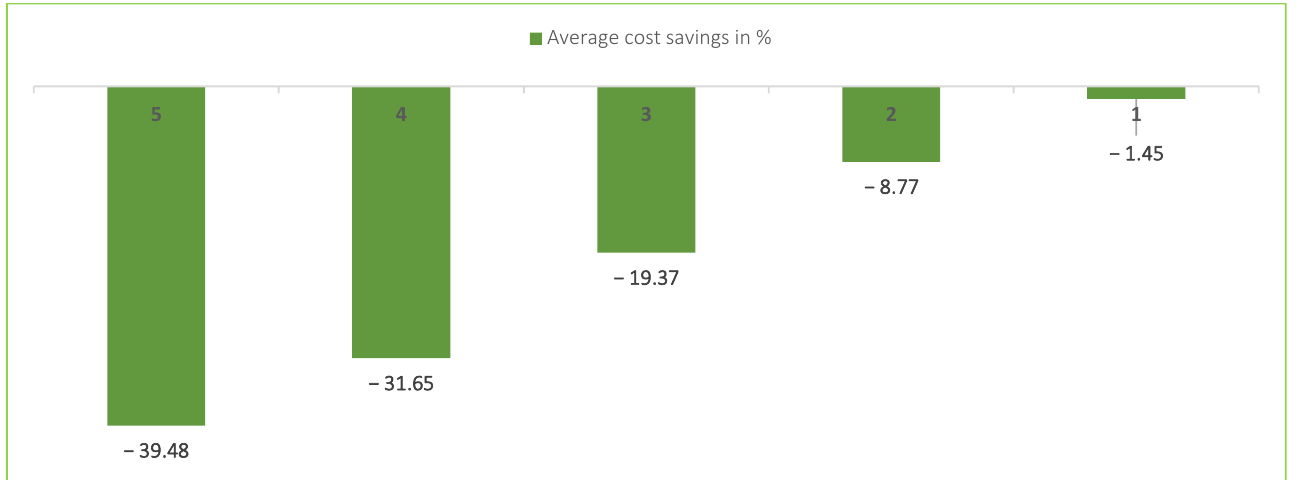
Figure 4. Percentage change in costs according to the ERP exploitation level.